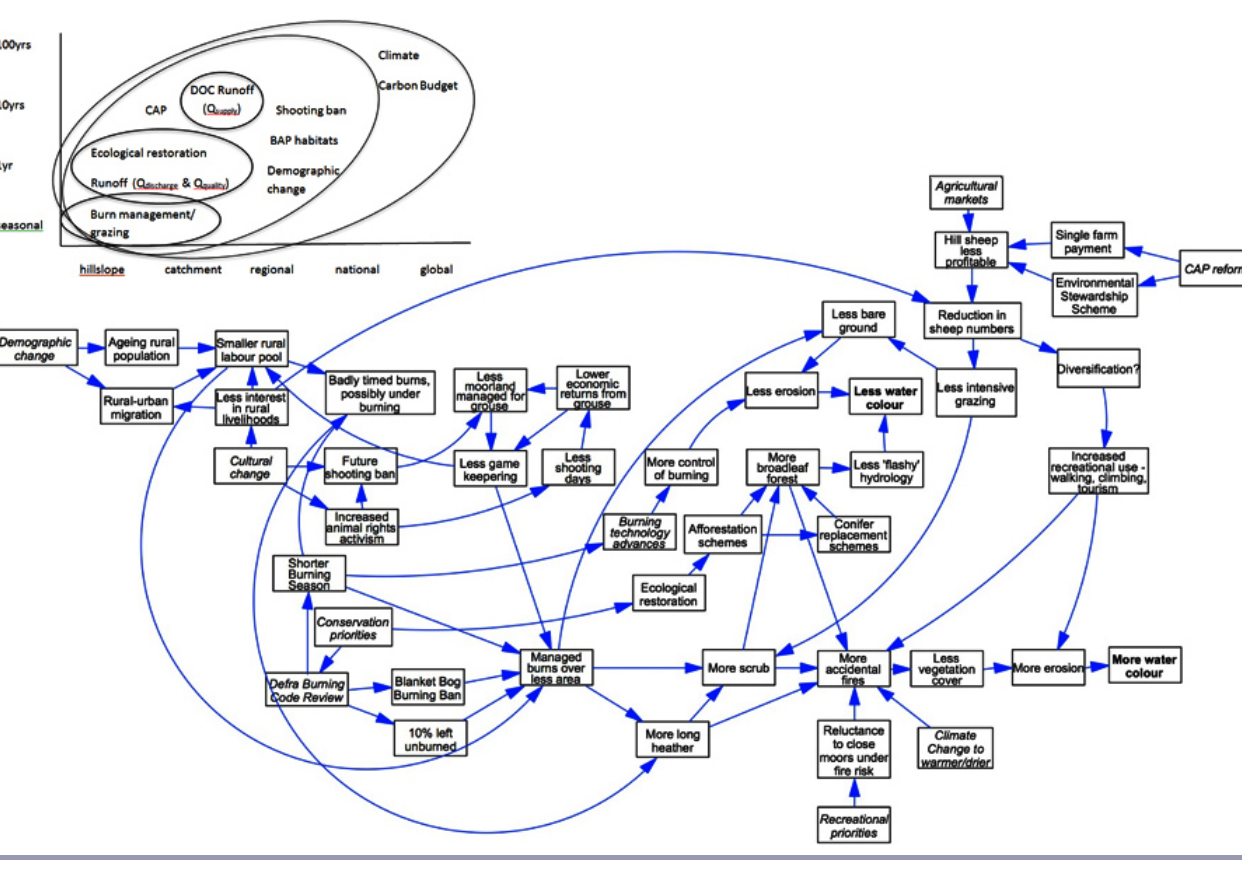
Fig. 2 . Conceptual submodel of socioeconomic and biophysical processes related to burning management in the uplands of the Peak District National Park, showing (inset) how many of the processes represented in this model interact at different spatial and temporal scales (CAP = Common Agricultural Policy reform; DOC = Dissolved Organic Carbon; BAP = Biodiversity Action Plan; adapted from Prell et al.